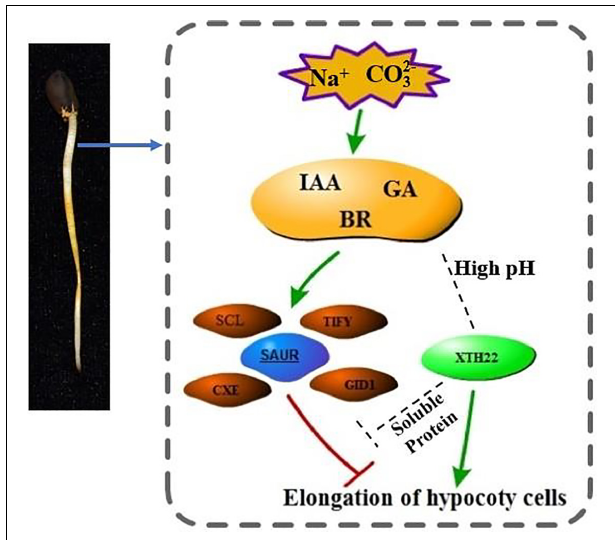
FIGURE 9 | The regulation model of hormone-related genes involved in DNA methylation under Na + stress. Under Na + stress, DNA methylation mediates the transcriptional changes of related genes mainly related to IAA, GA, BR, including the up-regulation of SCL, TIFY transcription factors and stress response proteins such as CEX and CID1, and the expression of SAUR protein. The gene encoding XTH22 protein is substantially up-regulated under high pH environment. XTH22 protein interacts with a soluble protein, and it promotes cell elongation under the concerted action of hormones, thereby alleviating the inhibition of Na + stress. The mechanism of interaction between XTH22 protein and hormones remains unclear, thus we use the gray dotted line to mark the